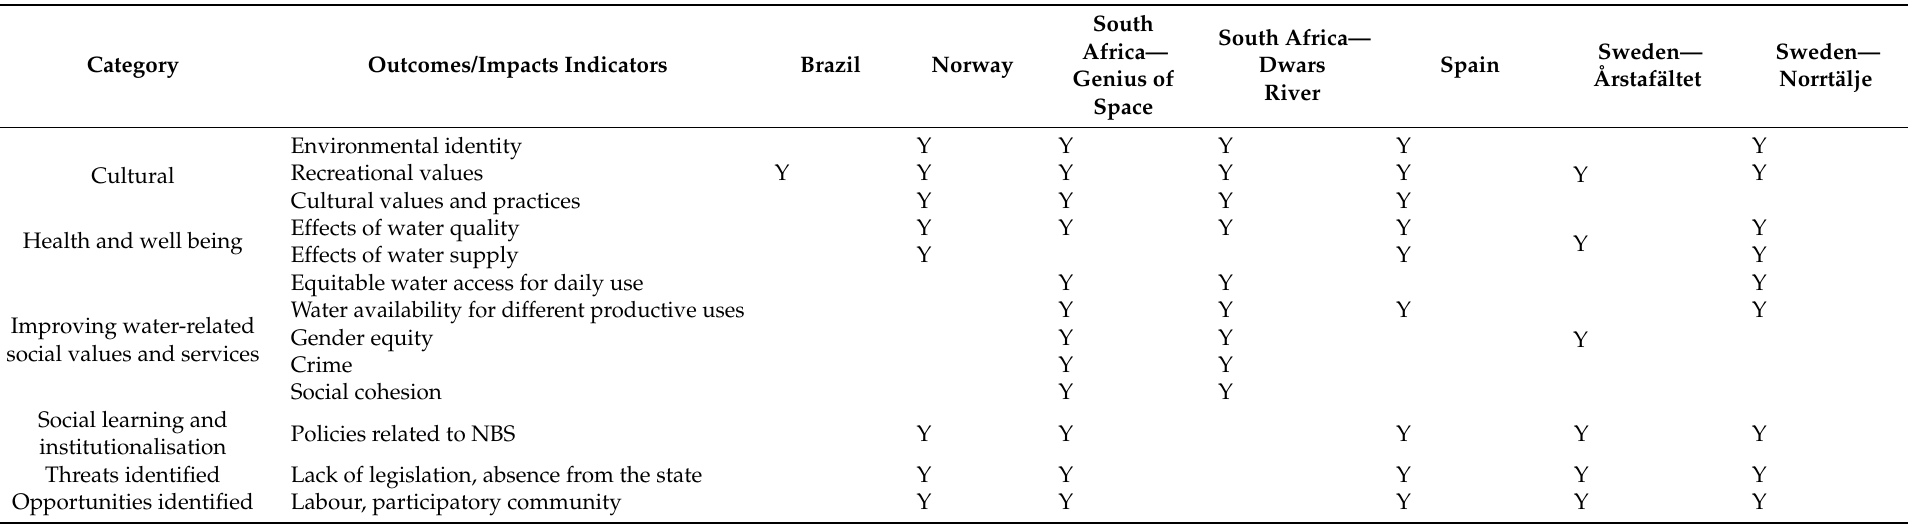
Table 7. Result-based social indicators according to whether each case study considered the indicator as relevant to be assessed (indicated with ‘Y’ for